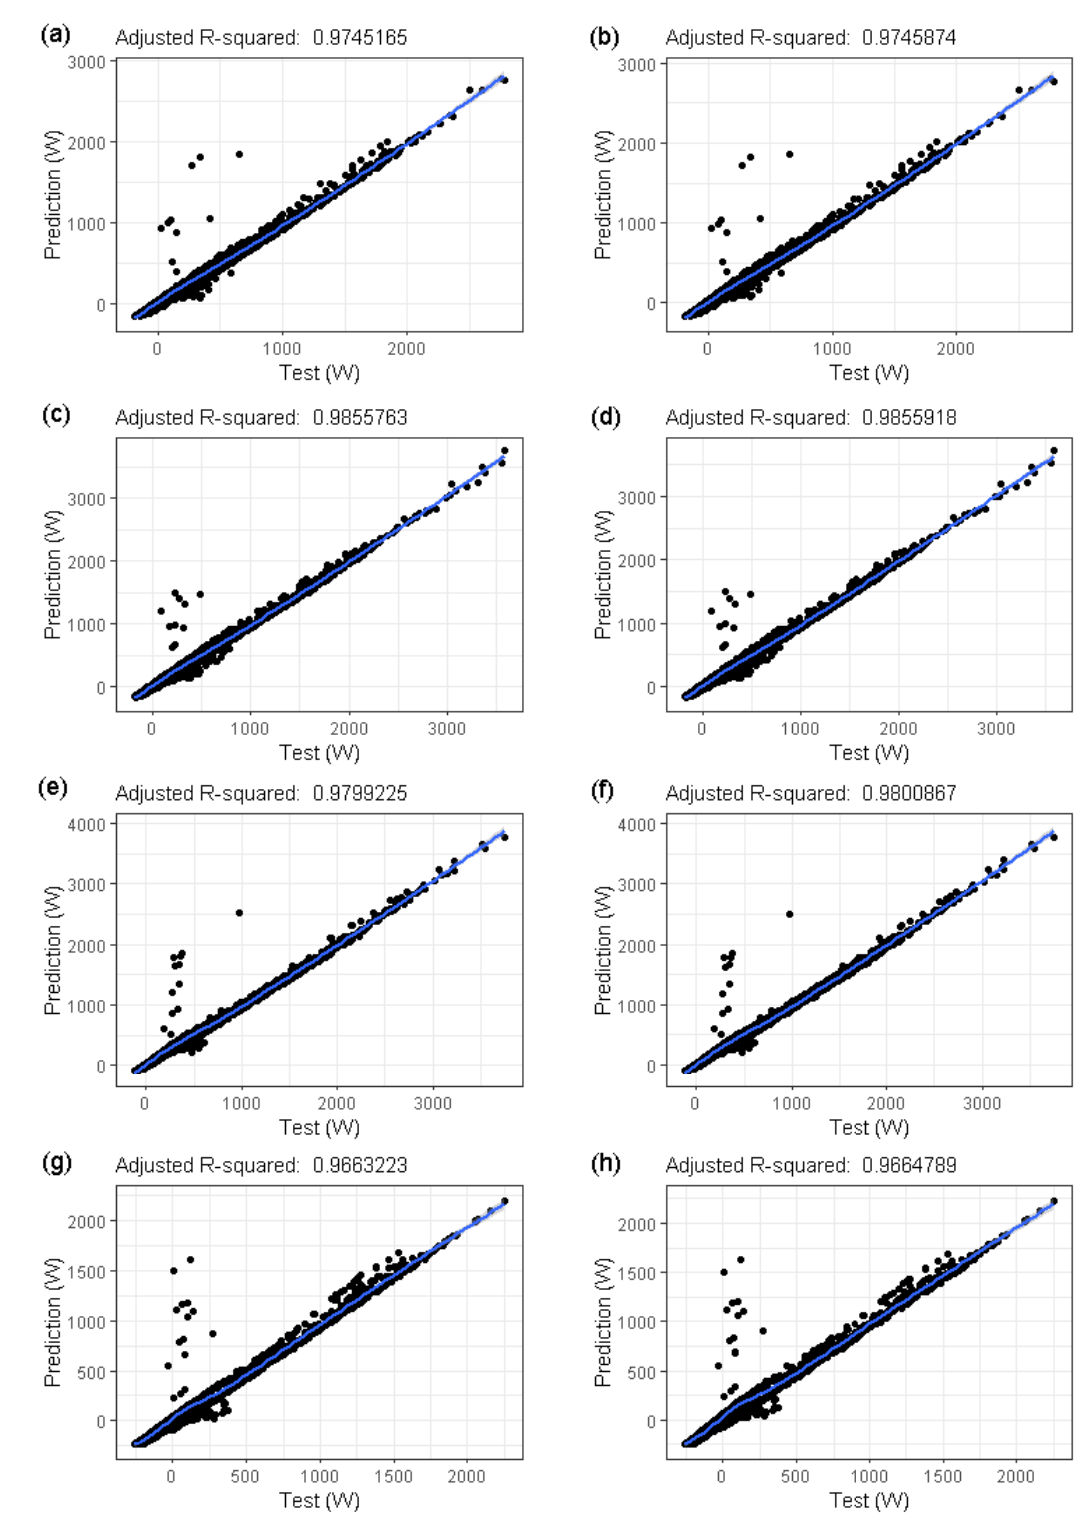
Figure 8. Comparison of the prediction and the test results for selected models of different seasons: ( a ) autumn — prediction vs. test for all data; ( b ) autumn — prediction vs. test for autumn data; ( c ) spring — prediction vs. test for all data; ( d ) spring — prediction vs. test for spring data; ( e ) summer — prediction vs. test for all data; ( f ) summer — prediction vs. test for summer data; ( g ) winter — prediction vs. test for all data; ( h ) winter — prediction vs. test for winter data.